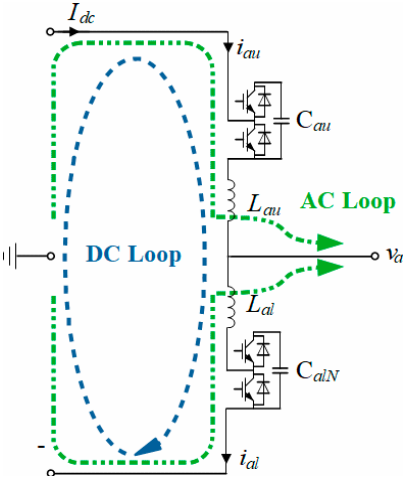
Figure 2. Diagram of MMC internal dynamics (phase A).